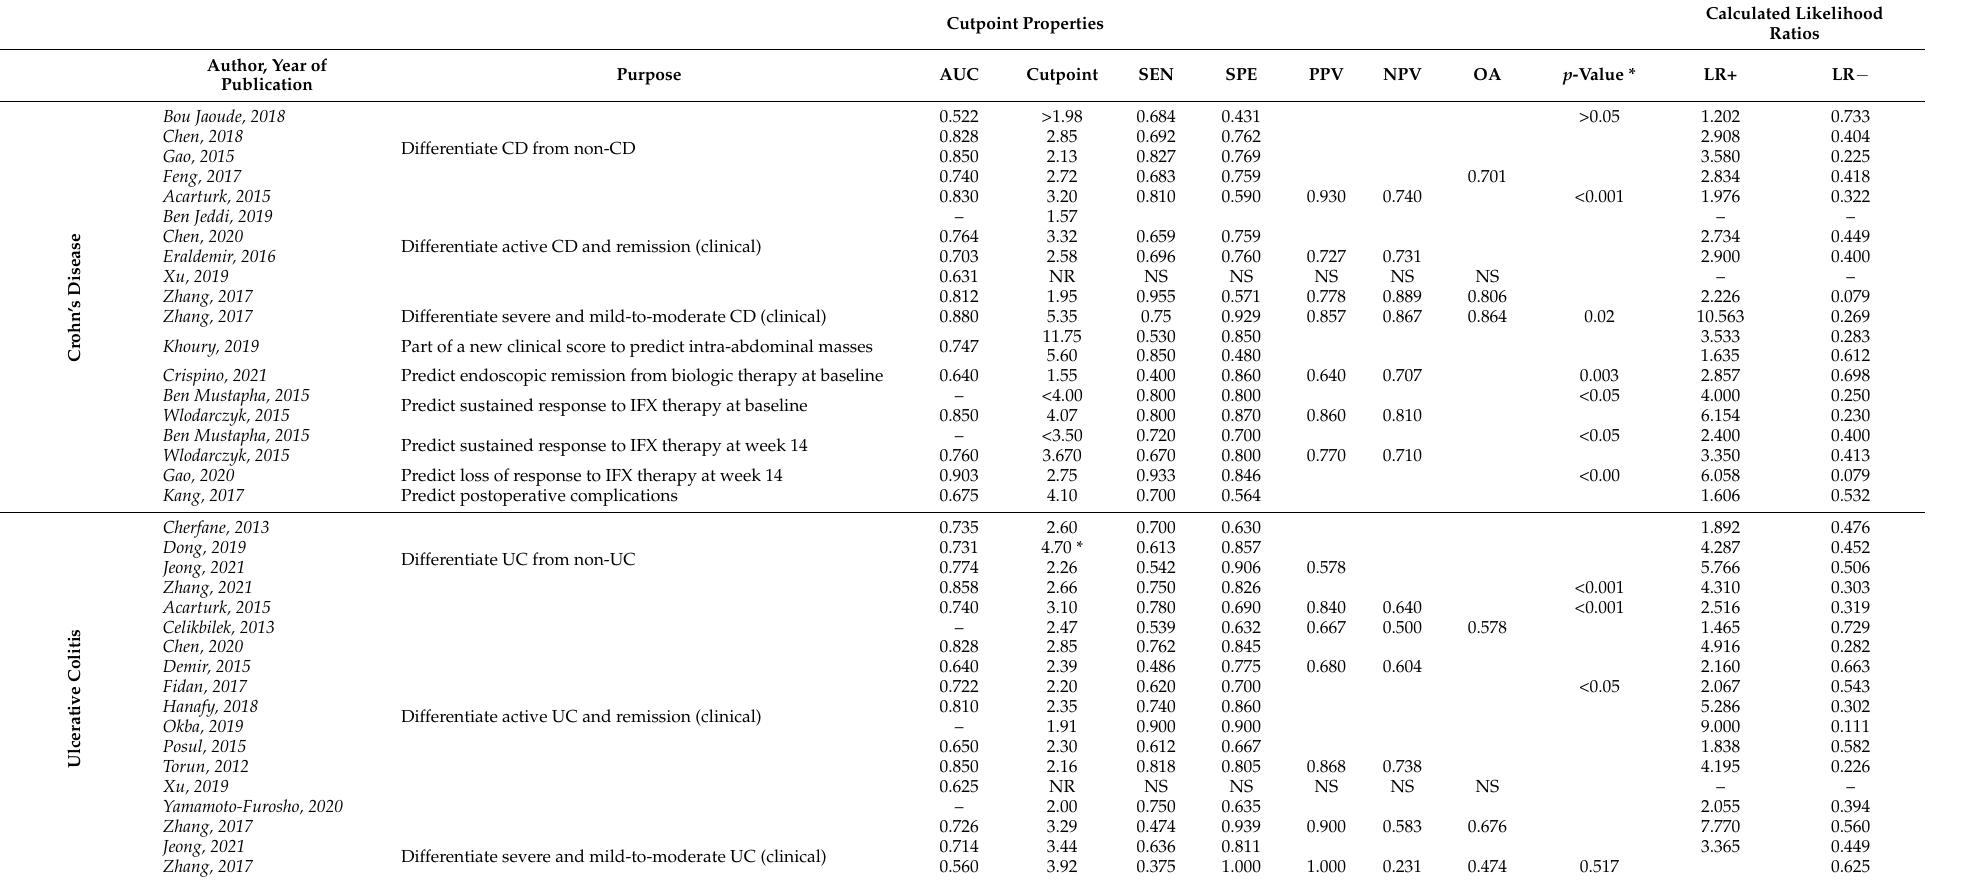
Table 2. Proposed NLR cutpoints by purpose and